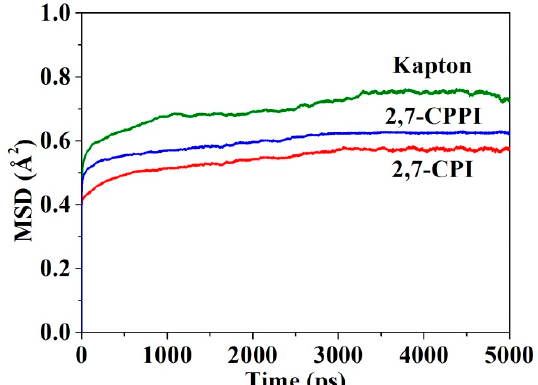
Figure 10. MSD of polymer chains as a function of time in Kapton, 2,7 ‐ CPPI and 2,7 ‐ CPI.